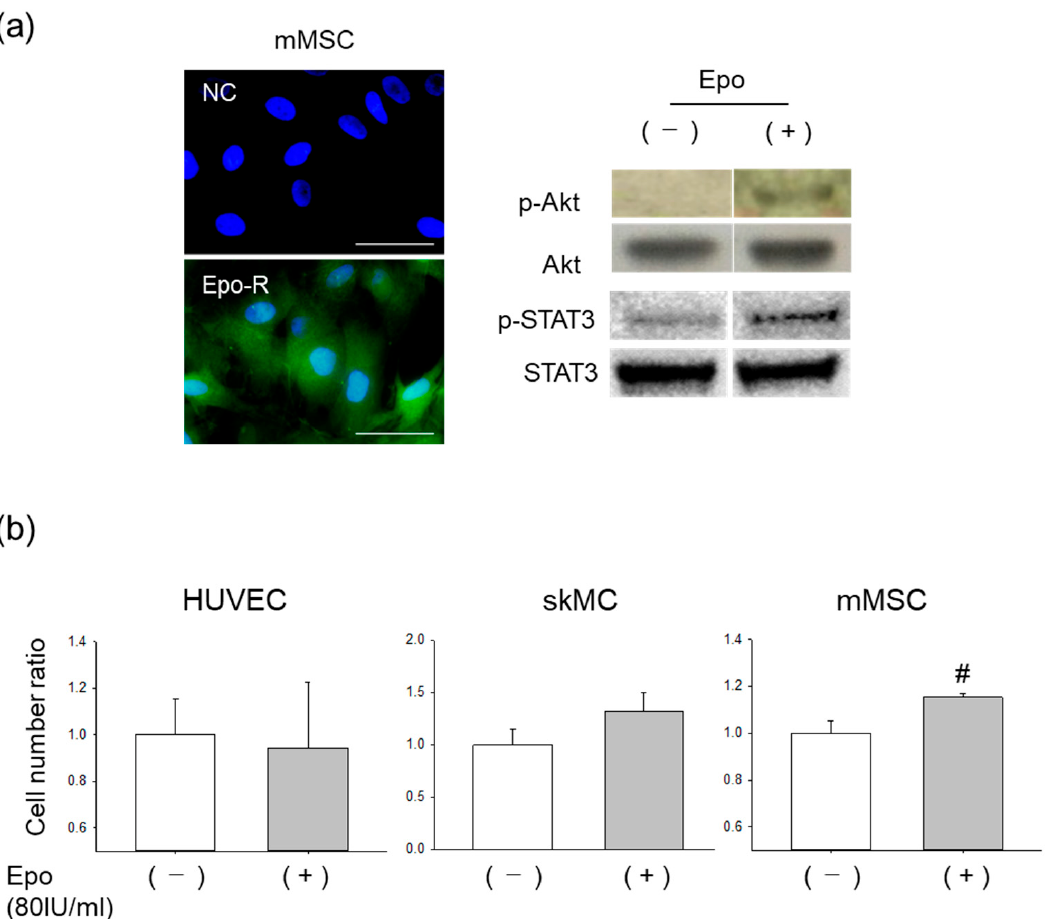
Figure 3. Proliferation of cultured mMSCs by Erythropoietin (Epo). ( a ) Left, Epo-R (green) expression in mMSCs. Nuclei were stained with DAPI (blue). NC, negative control. Bar = 50 µ m. Right, western blot analysis. Epo stimulated the phosphorylation of Akt and STAT3 in the mMSCs. Epo-R, erythropoietin receptor. ( b ) Efficacy of Epo stimulation on the propagation of HUVECs, skMCs, and mMSCs. N = 3 to 6. # p < 0.01. HUVECs, human umbilical cord vein endothelial cells.